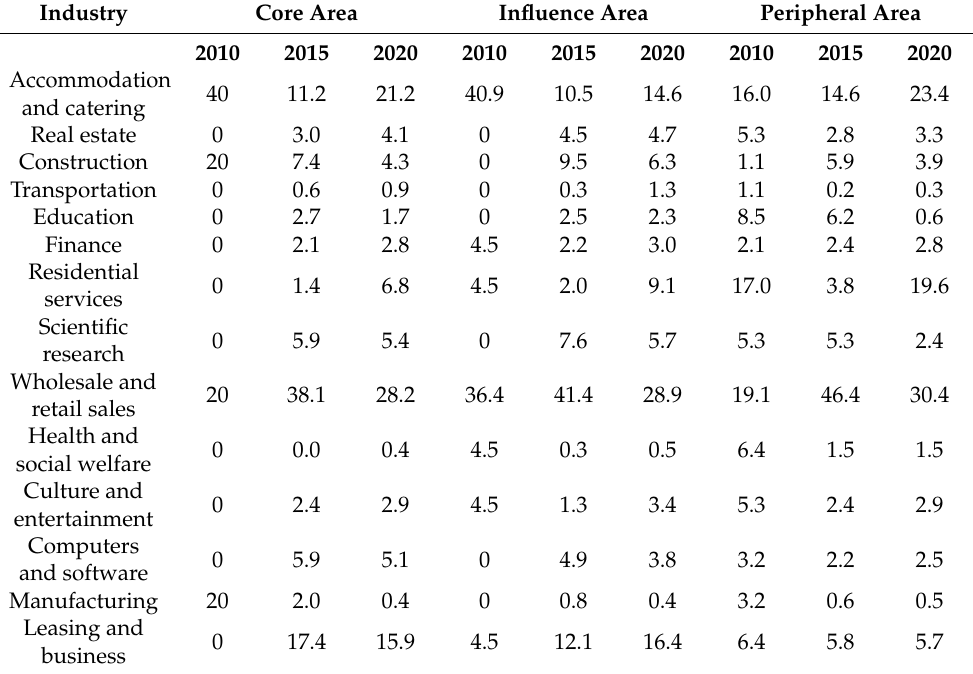
Table 3. Distribution characteristics of sub-industry circles in Zhengzhou East railway station